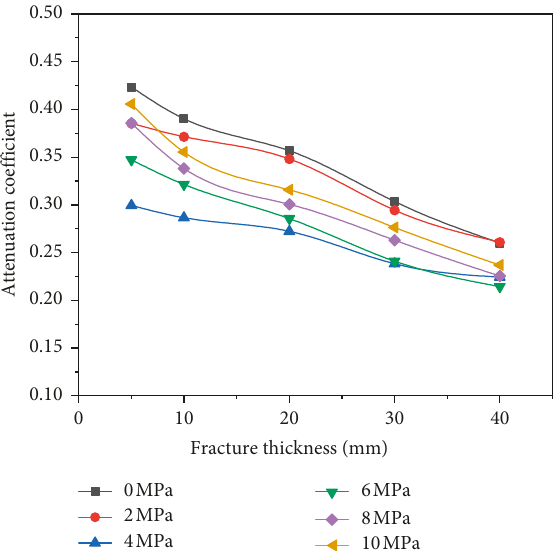
Figure 11: Variation of the attenuation coefficient with crack widths.